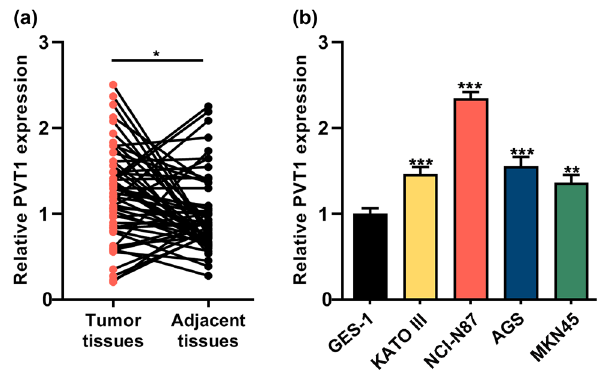
Figure 1: PVT1 was highly expressed in GC tissues and cell lines. ( a ) The expression of PVT1 in GC tissues ( n = 54 ) and adjacent normal tissues ( n = 54 ) was assessed by qRT - PCR. ( b ) The expression of PVT1 in human normal gastric mucosal cell line ( GES - 1 ) and four GC cell lines ( AGS, NCI - N87, KATO III and MKN45 cells ) was analyzed by qRT - PCR. All of the experiments were performed at least in triplicate.